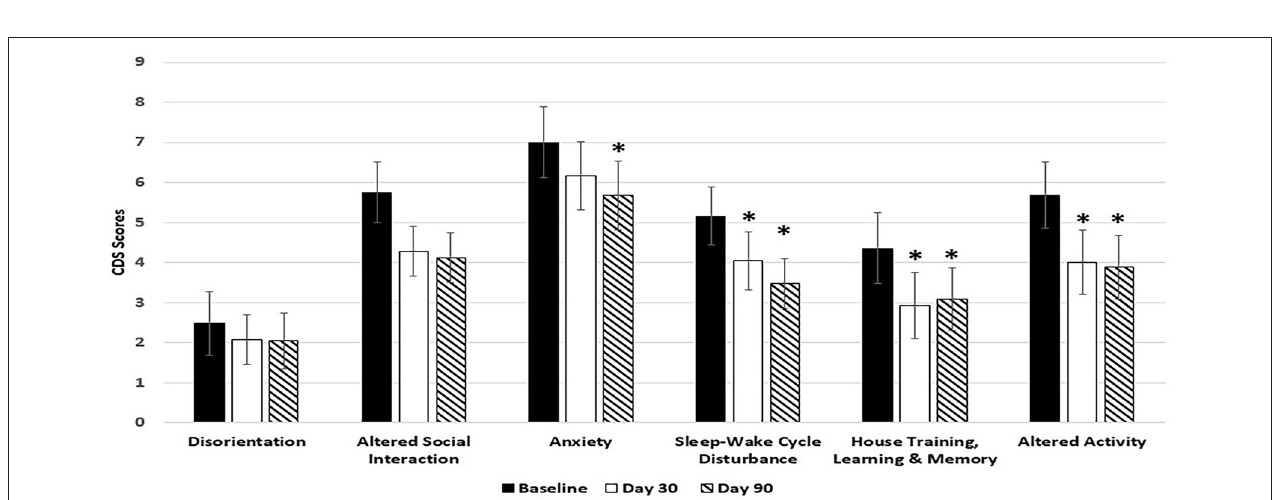
FIGURE 4 | Effects of Control diet on CDS signs at day 30 and day 90. Twenty-nine client owned dogs were assessed for six different behavioral signs of cognitive dysfunction syndrome (CDS) and then placed on the control diet. The dogs were re-assessed after 30 days and again after 90 days. The bars illustrate Means ± SEM for each of the measures at baseline, 30 days and 90 days. Fisher Exact Probability test for multiple comparisons was used to compare baseline with day 30 and day 90. The asterisks indicate statistically significant differences ( p < 0.05) from baseline. Four dogs dropped out of the